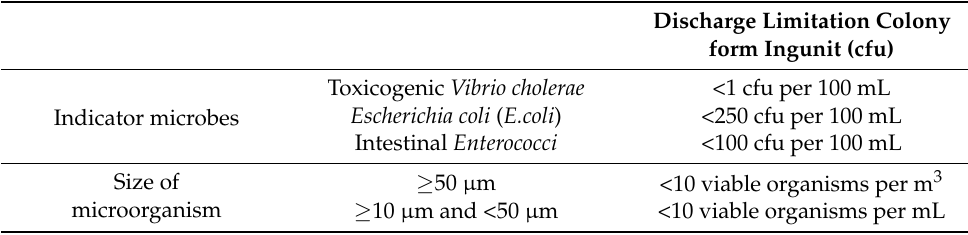
Table 1. Microorganism discharge limitations based on the IMO D-2 Standard (IMO, 2004)